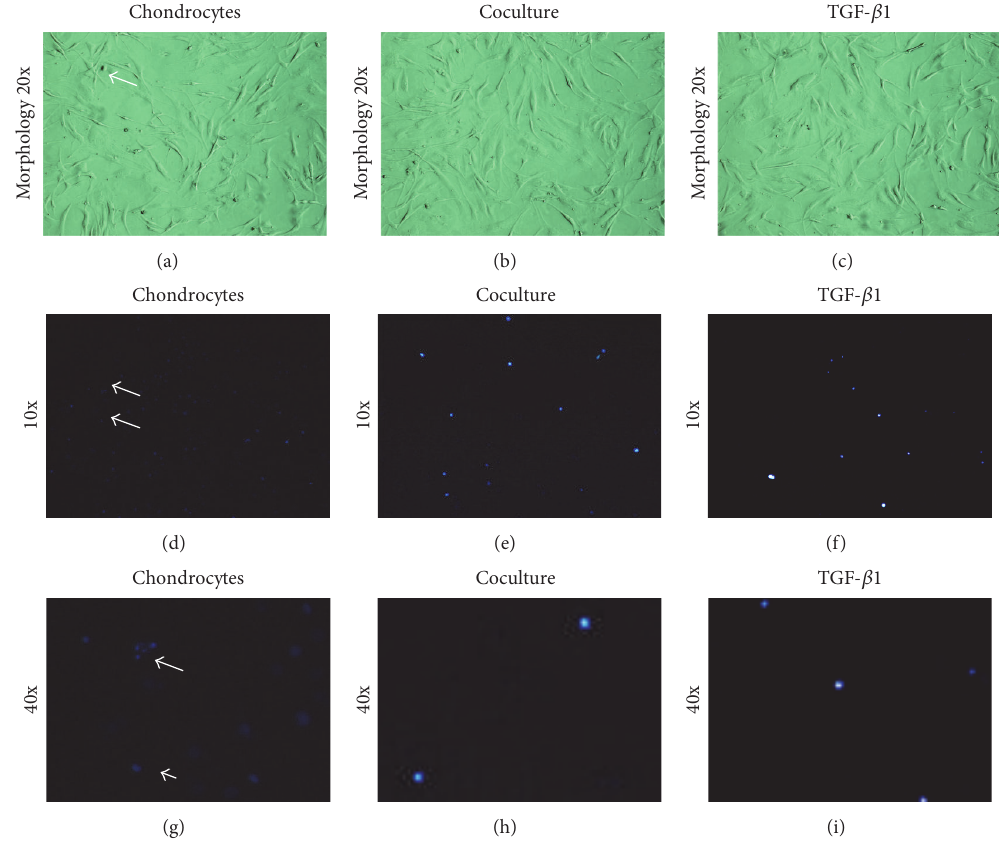
Figure 7: Morphology ((a)–(c)) and apoptosis assay ((d)–(i)) of chondrocytes cultured with control medium ((a), (d), and (g)), ADSCs cocultured system ((b), (e), and (h)), and TGF- 𝛽 1-containing medium ((c), (f), and (i)) for 5 days. Morphology assay showed some membrane blebbing in the chondrocytes cultured with control medium (a), and the cell blebbing numbers were decreased in chondrocytes cultured with ADSCs cocultured system (b) and TGF- 𝛽 1-containing medium (c). Hoechst 33258 staining showed many chromatin condensations in chondrocytes cultured with control medium ((d), (g)), and much less apoptosis of cells was found in chondrocytes cultured with ADSCs cocultured system ((e), (h)) and TGF- 𝛽 1-containing medium ((f), (i)). The images of (g), (h), and (i) were the corresponding higher magnification images of (d), (e), and (f),